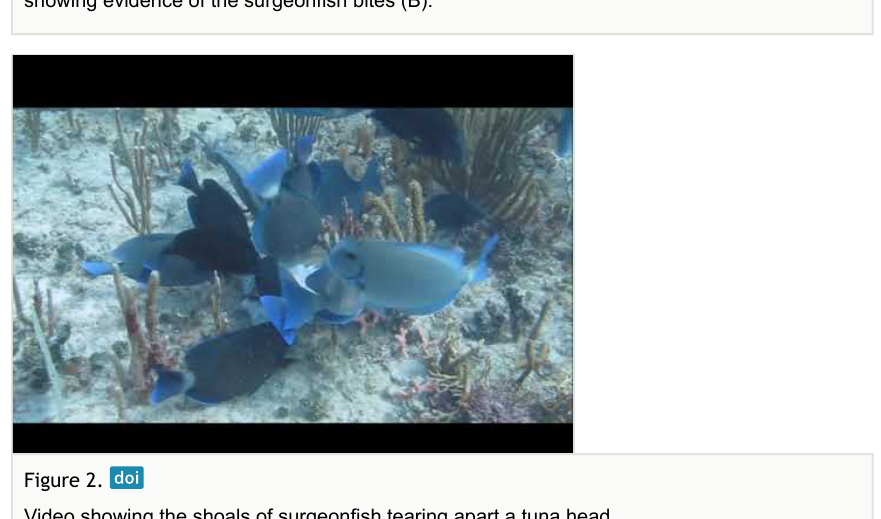
Figure 2. Video showing the shoals of surgeonfish tearing apart a tuna